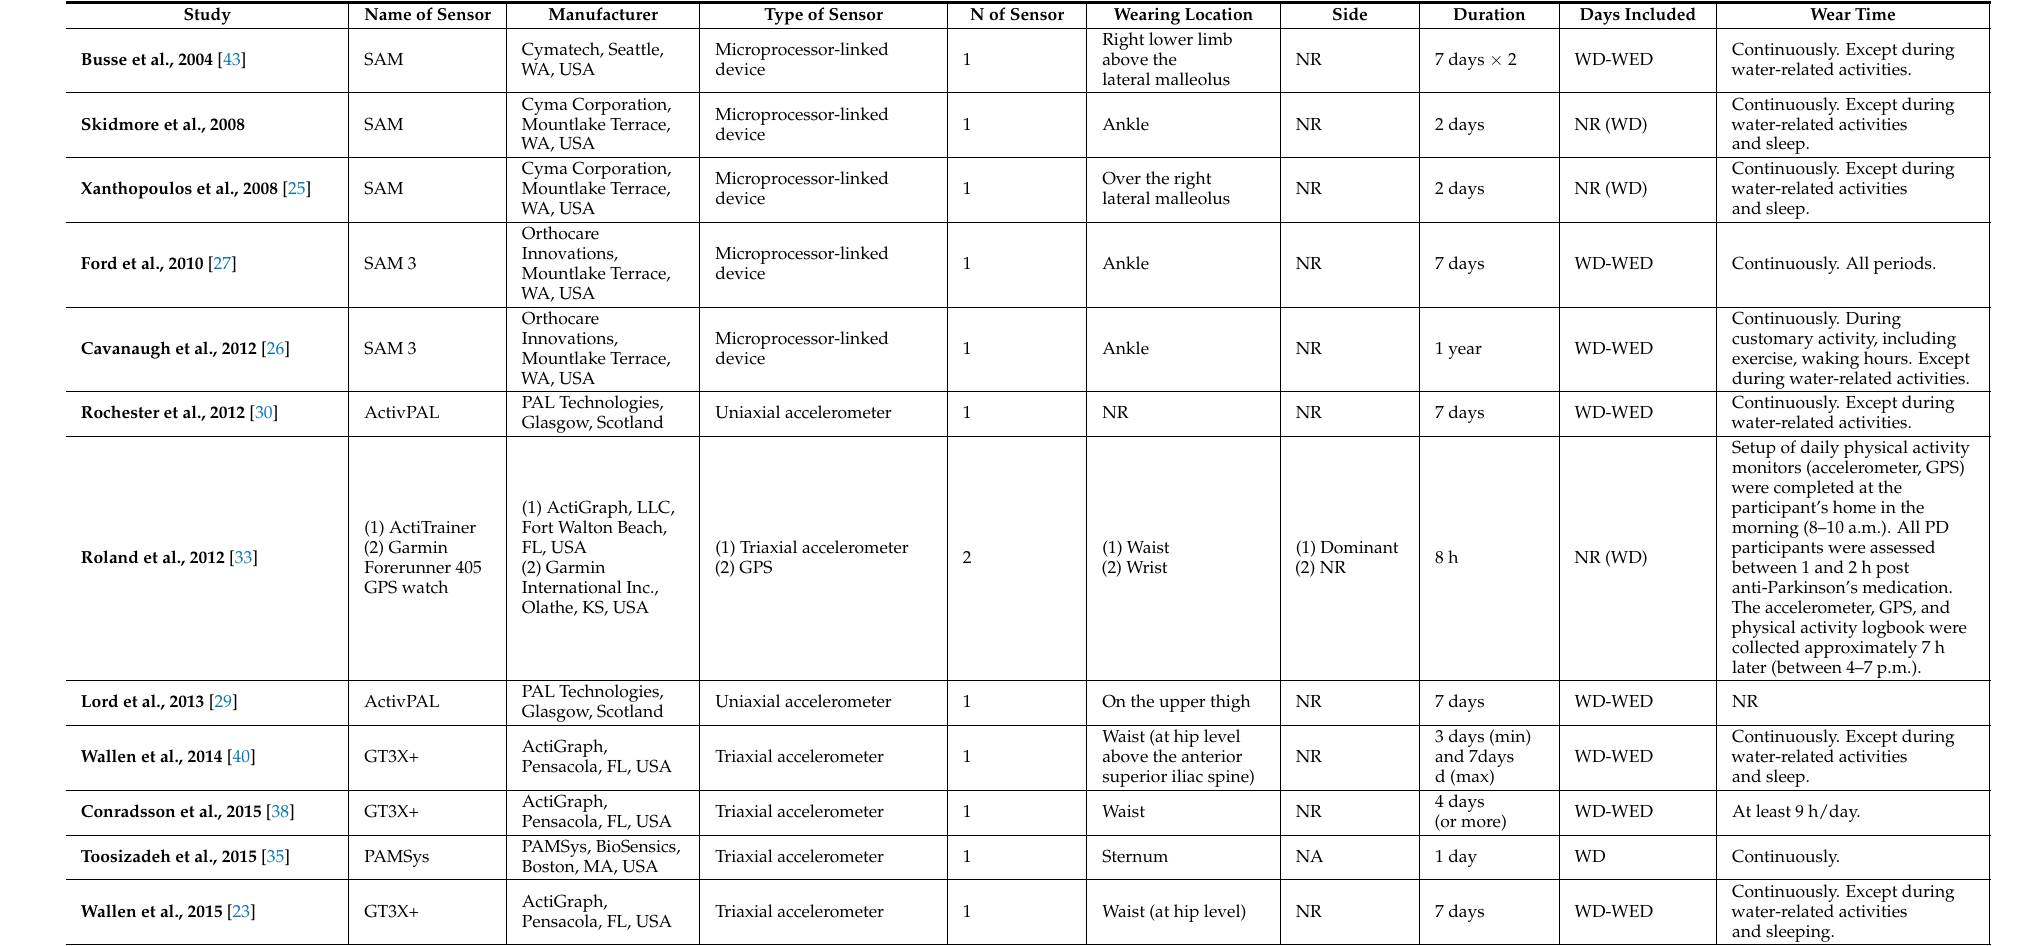
Table A3. Characteristics of sensors and conditions of data